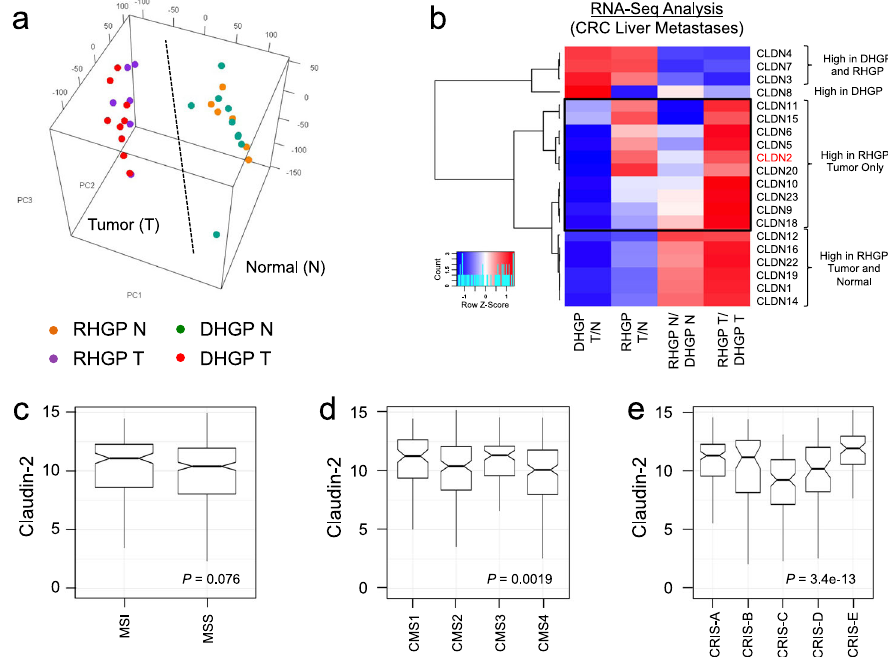
Fig. 2 Distinct Cldn mRNA expression pro fi les are associated with desmoplastic and replacement-type CRCLMs. a PCA analysis revealed that all tumor or normal samples clustered together. b Gene expression heatmaps of claudin family members in the dissected samples. A blue to red gradient represents low to high gene expression levels. RHGP Replacement Histopathological Growth Pattern, DHGP Desmoplastic Histopathological Growth Pattern. c – e Differences in CLDN2 expression ( Y -axis) between 377 colon adenocarcinoma tissue samples, from the PCAWG dataset, classi fi ed according to the MSI ( c ), CMS ( d ), and CRIS ( e ) subtypes are shown in notched boxplot format. Boxes represent the 25th (lower border), median, and 75th (higher border) percentile of the CLDN2 expression distribution in each subgroup, and whiskers extend to the 5th (bottom) and 95th (top) percentile. The notches represent the 95% con fi dence interval around the median. Outliers are shown as dots. P -value resulting from comparing the distributions with a Wilcoxon signed rank test are